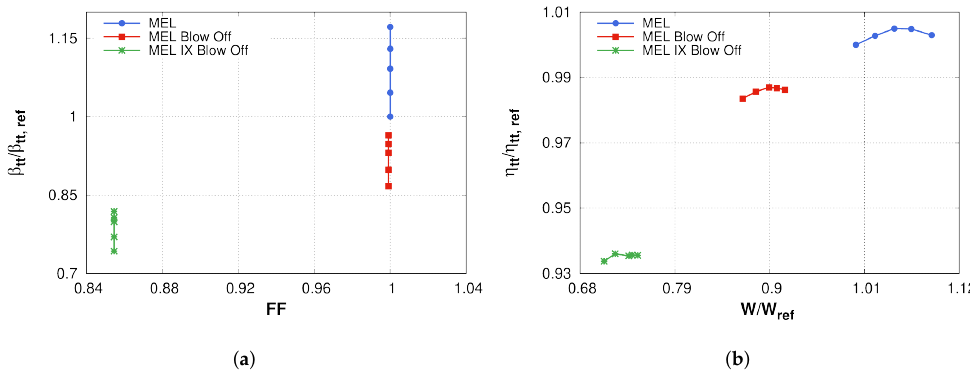
Figure 5. Overall pressure ratio ( a ) and efficiency ( b ).